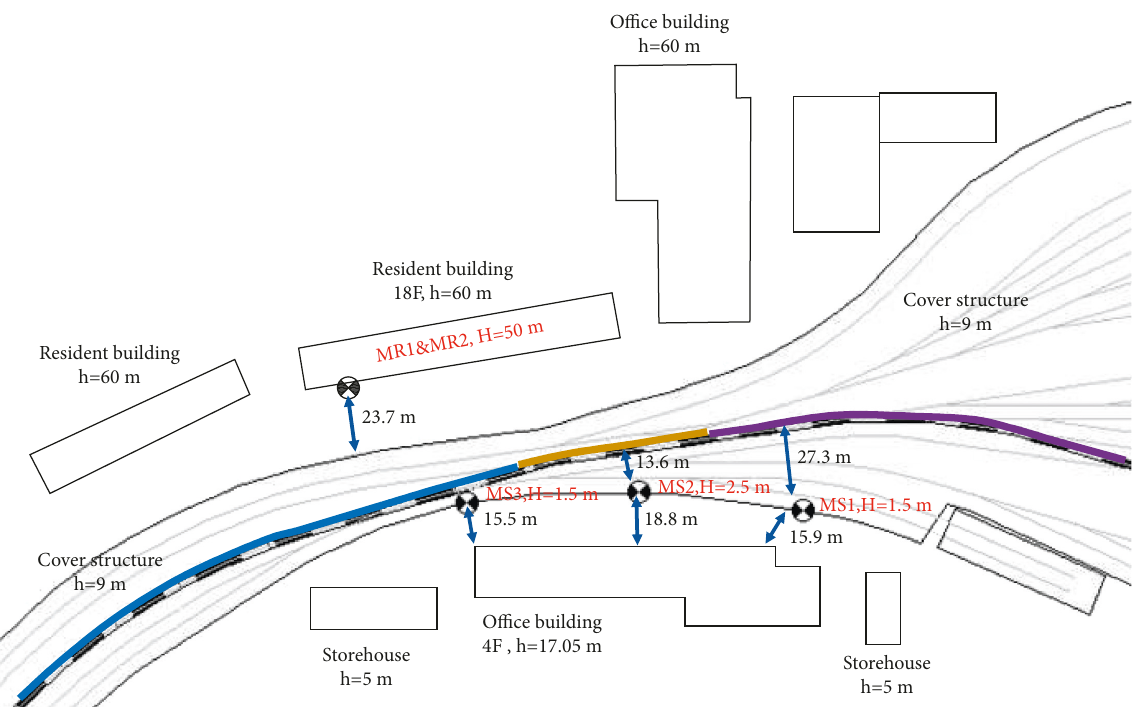
Figure 4: The detailed location of measurement points.